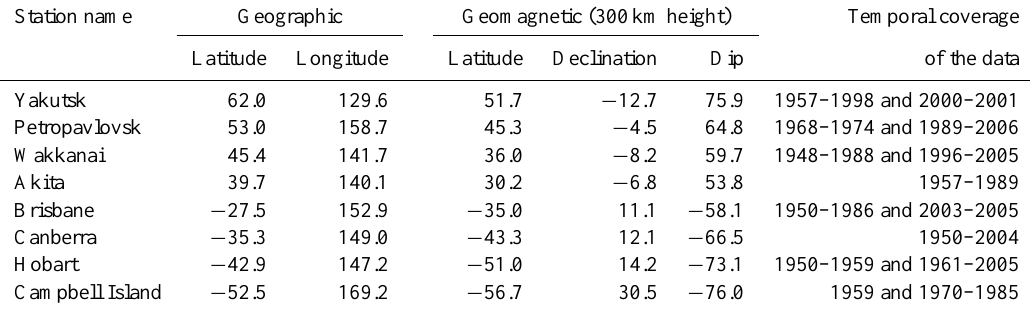
Table 1. Information list of ionosonde stations used in this